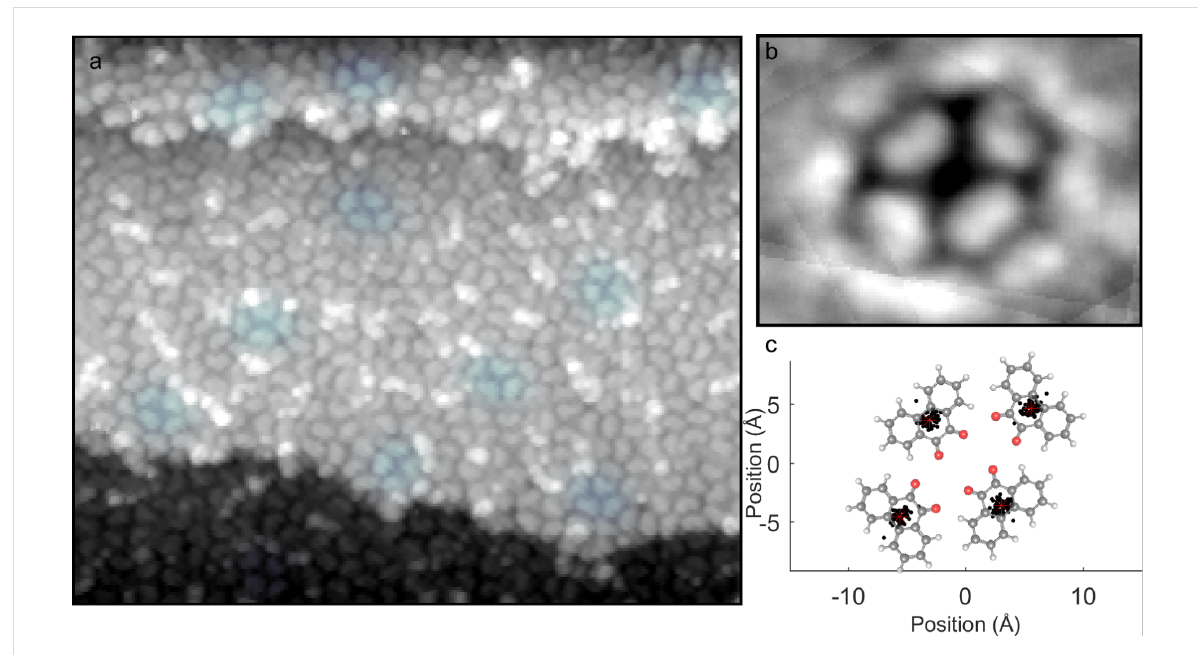
Figure 4: a) A 250 Å × 212 Å STM topography image containing a region of disordered molecules and rectangular tetramers, with some representa- tive tetramers highlighted in blue. A composite image of the 59 fully-resolved tetramers present in this image is shown in panel b), with the proposed molecular conformation as an overlay. The average position of each molecular centroid (red asterisk) is plotted with the actual measured position of each centroid (black) for these 59 clusters in c).